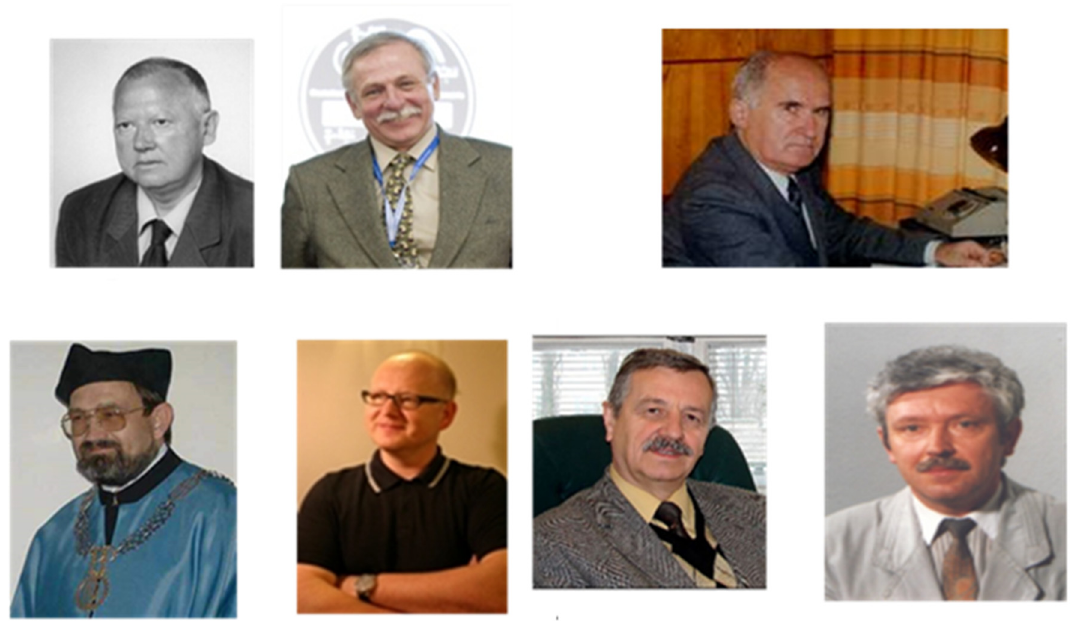
Figure 7. Representatives of the Pozna´n analytical community, top row from the left:.J. Szymanowski, M. Stobecki, W. Szczepaniak, bottom row from the left: A. Voelkel, H. Jele´n, J. Nawrocki, W. Wasiak.